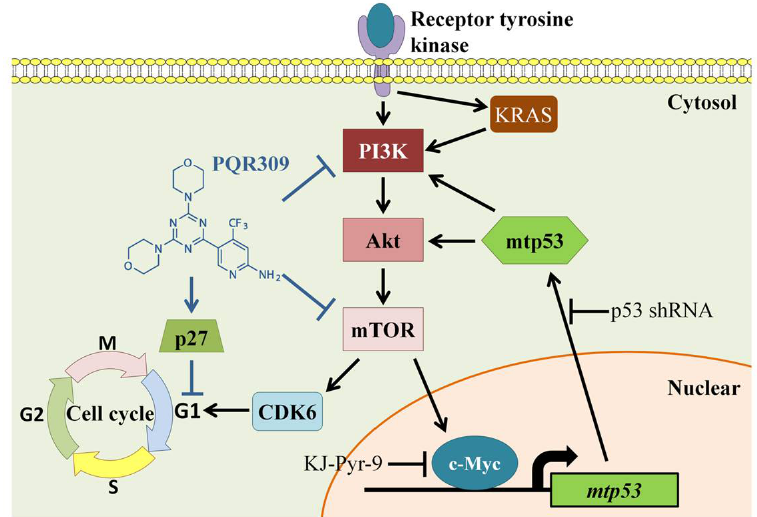
Figure 8. A suggested model of PQR309 induced cell cycle arrest by inhibiting